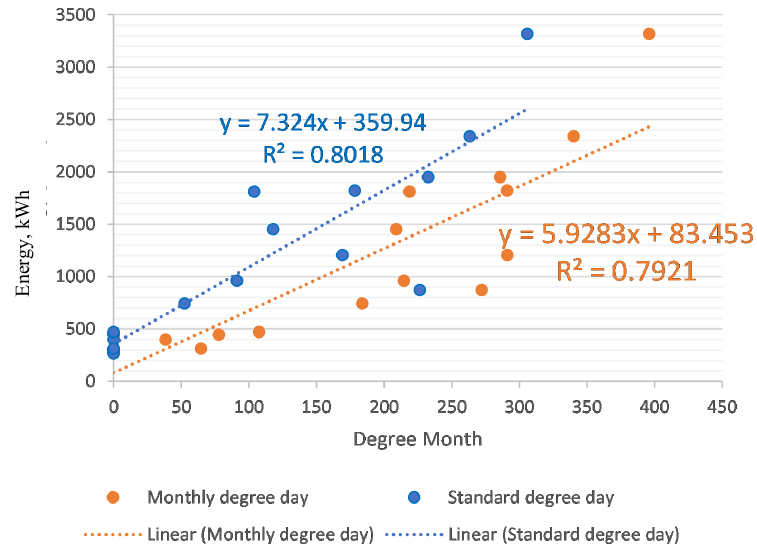
Fig. 3. Energy consumption versus degree-days for house 1 with monthly